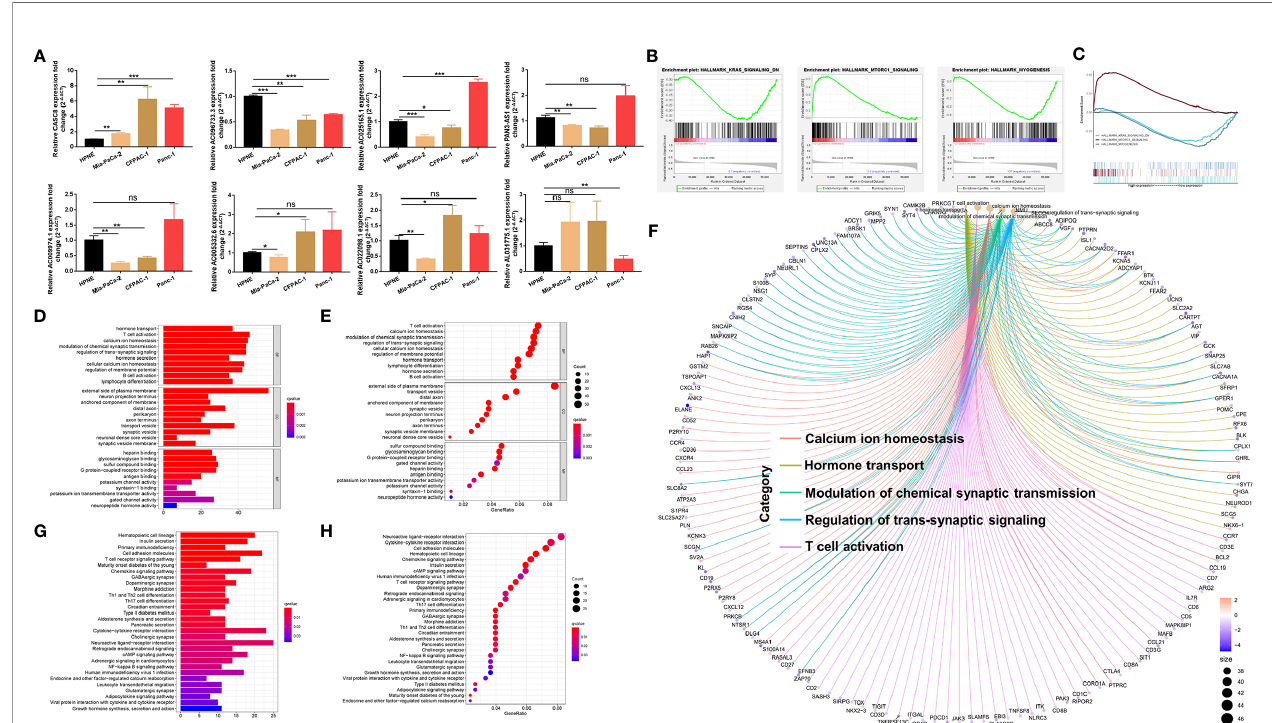
FIGURE 6 | Validating the expression level of the m5C related lncRNAs in vitro and functional enrichment analysis. (A) qRT-PCR experiments were performed to detect the expression of the 8 m5C related lncRNAs in HPNE cells and three pancreatic cancer cells respectively. (B, C) GSEA results showed signi fi cant enrichment signaling pathways in the high-and low-risk groups. (D – F) GO analysis was performed to detect biological processes that involved in the high-or low-risk groups. (G, H) KEGG pathway analysis results indicated the enriched signaling pathways associated with the m5C related lncRNAs risk scores. ns, not signi fi cant, *P < 0.05, **P < 0.01, ***P <